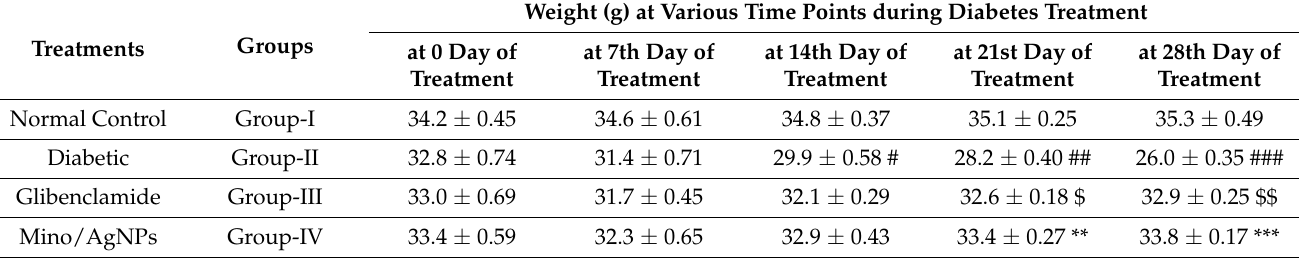
Table 1. Measurement of the body weight of the mice in various treatment groups.